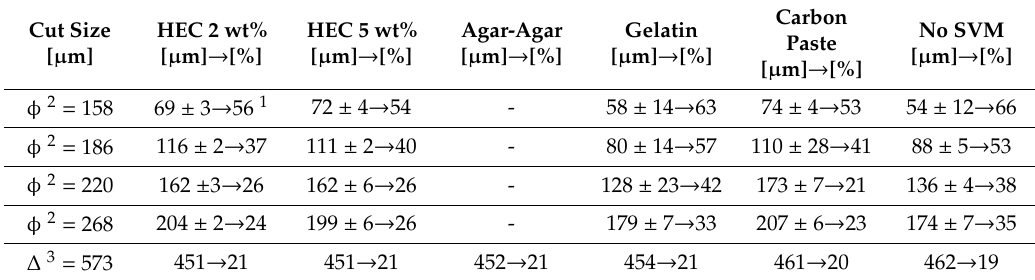
Table 1. Hole and pitch dimensions (mean value and standard deviation rounded to nearest µ m) after firing and calculated shrinkage for the di ff erent test